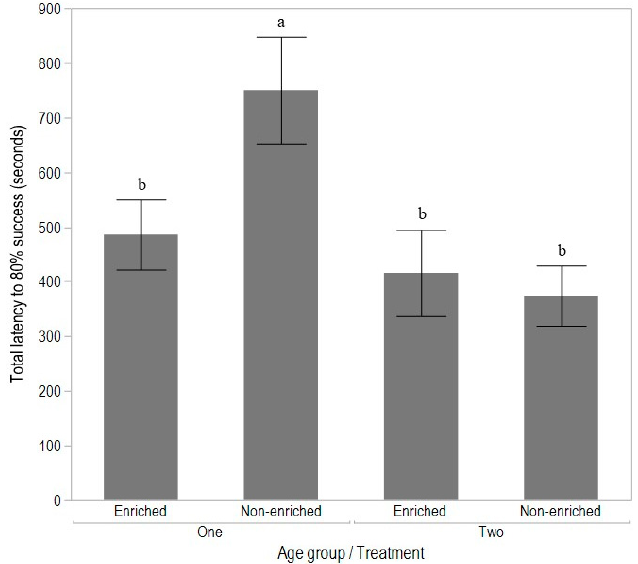
Figure 3. The total latency to minimum 80% success (seconds) during T-maze learning for birds from enriched or non-enriched early rearing treatments and tested as Age group 1 (15 to 16 weeks of age) or Age group 2 (17 to 18 weeks of age). Different superscripts indicate significant differences between treatments across testing age groups ( p < 0.05).